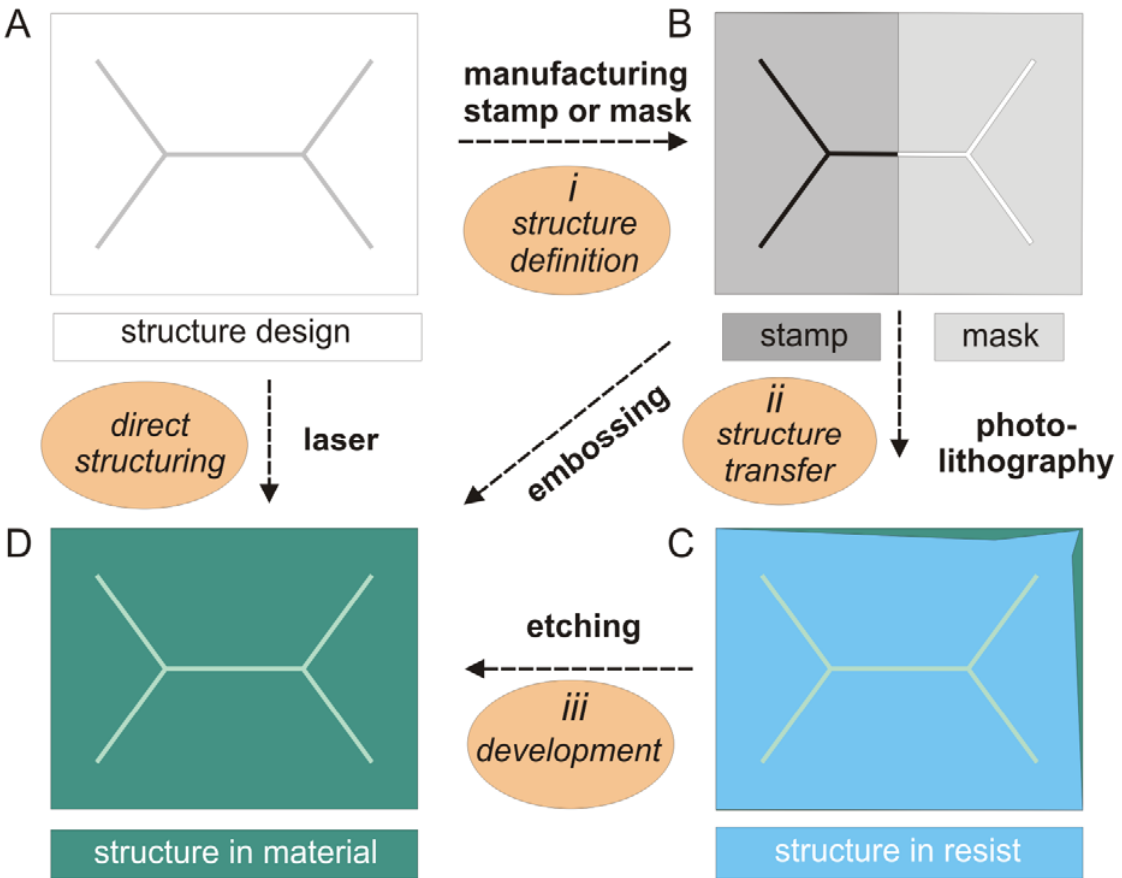
Figure 1. Structuring techniques for materials used in